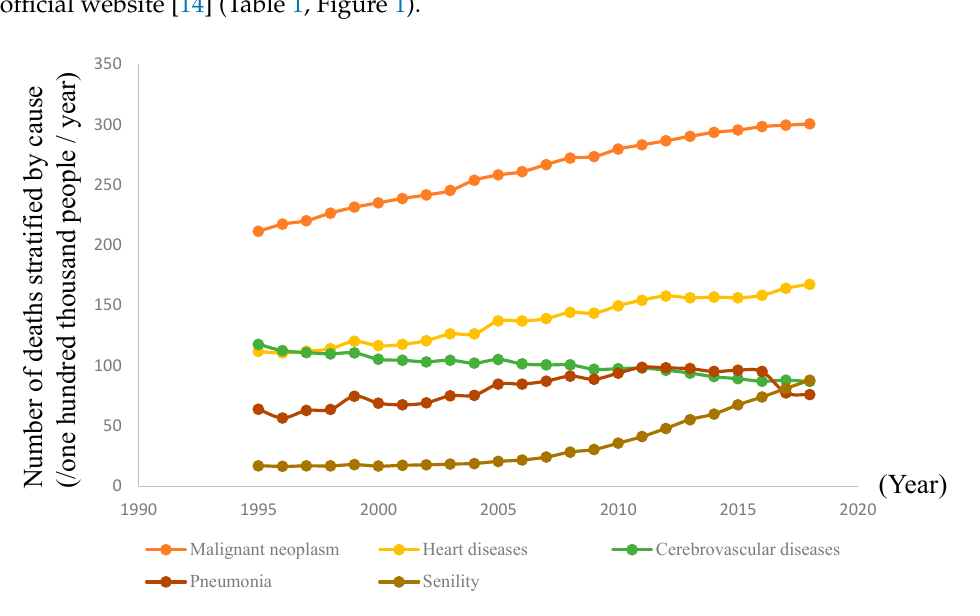
Figure 1. Changes in the number of deaths stratified by cause among all 47 prefectures in Japan.